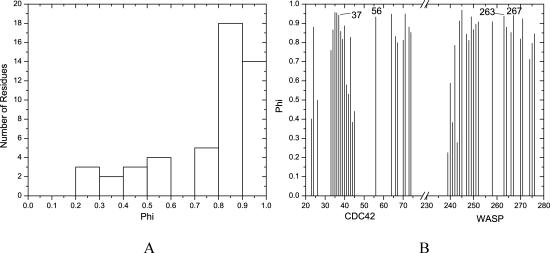
Distribution of Phi Values versus Protein-Primary Sequence(A) Distribution of phi values, and (B) phi values along the primary sequences of CBD portion of WASP and Cdc42.